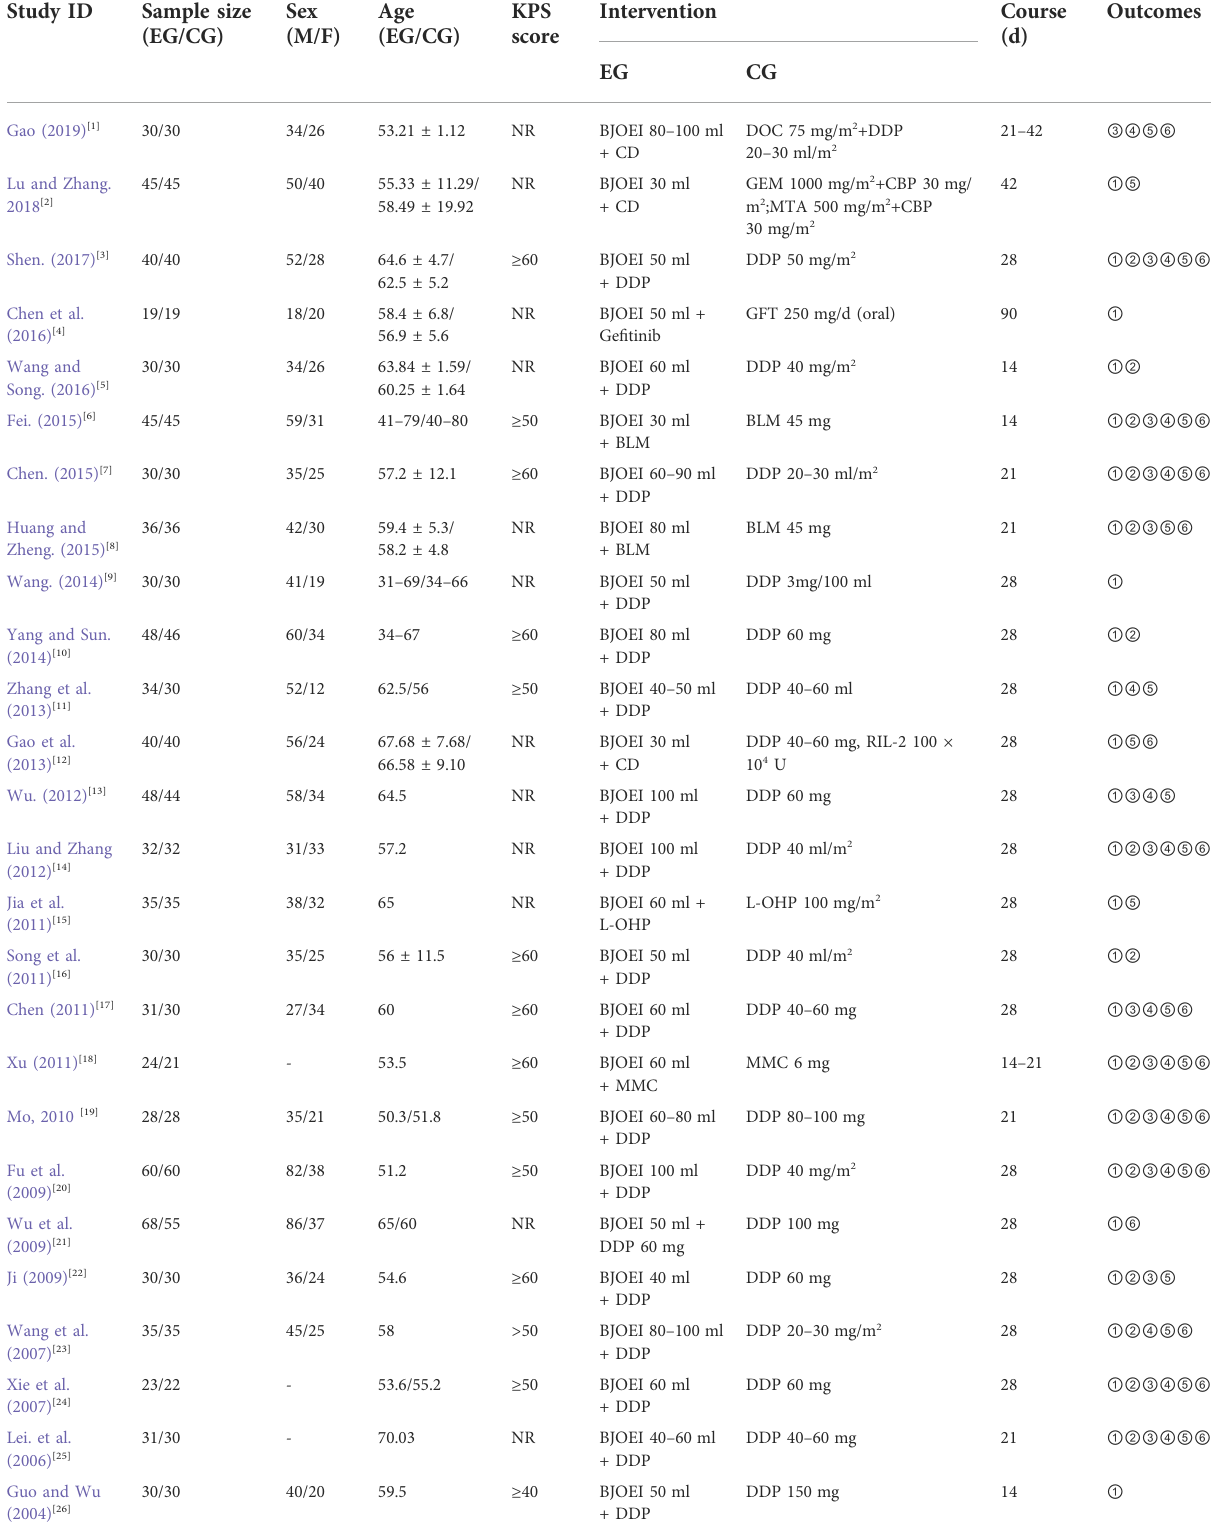
TABLE 1 Included in the list of basic characteristics of the